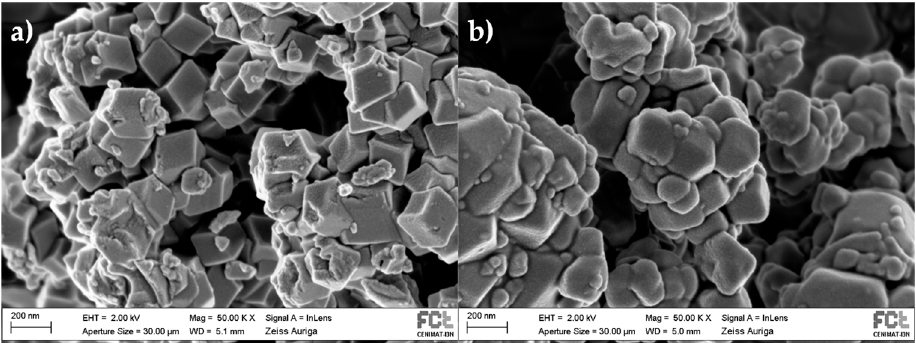
Figure 3. SEM micrographs (×50k magnification) of: ( a ) ZIF-8; and ( b ) [C 6 MIM][B(CN) 4 ]@ZIF-8 (low).